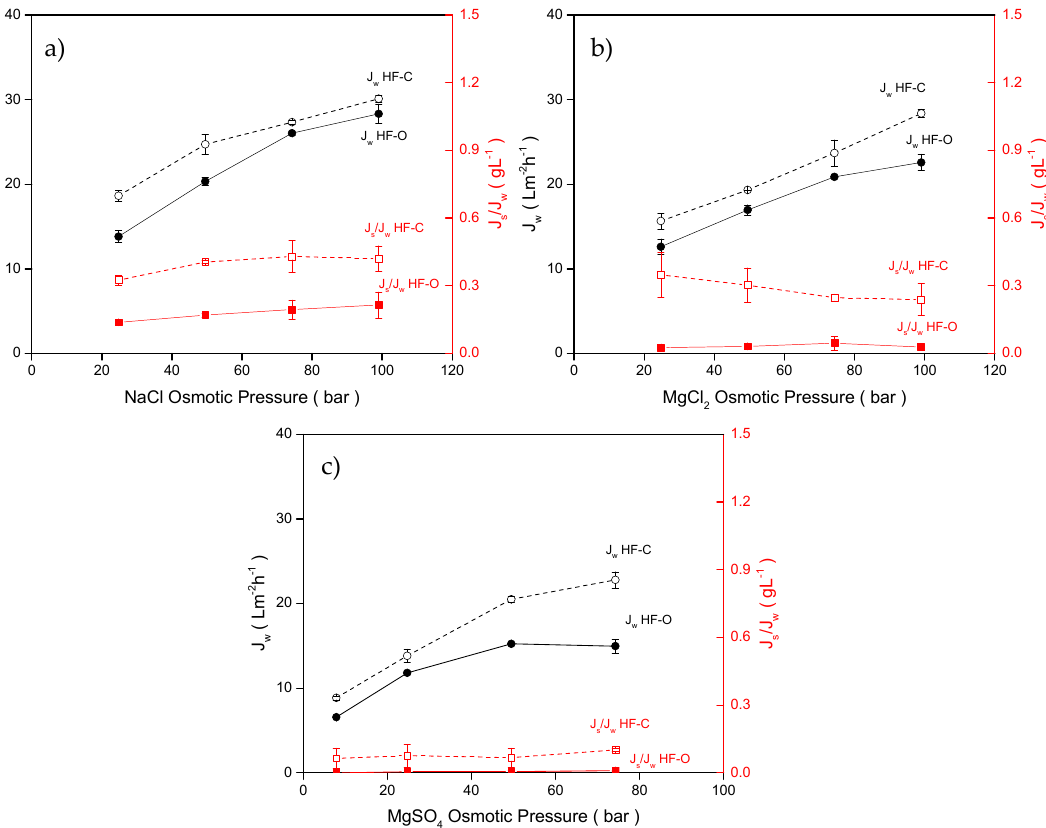
Figure 9. J w and J s / J w for HF–C and HF–O modules as a function of the osmotic pressure of ( a ) NaCl DS solution, ( b ) MgCl 2 DS solution, and ( c ) MgSO 4 DS solution. All tests were carried out using DI water as an FS. The feed flow rate was 100 L · h − 1 , the draw flow rate was 25 L · h − 1 , and TMP was 0.2 bar (n = 2).